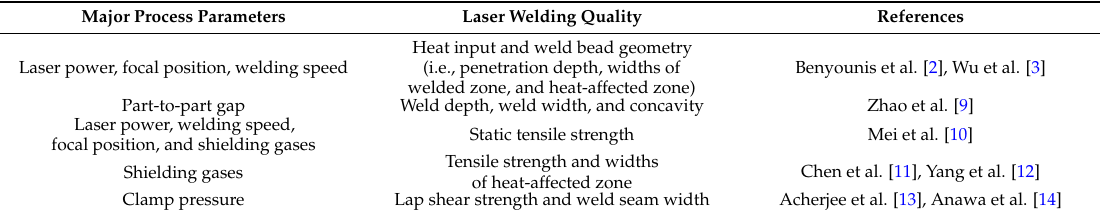
Table 1. The major process parameters in the laser lap welding of galvanized steel from literature.